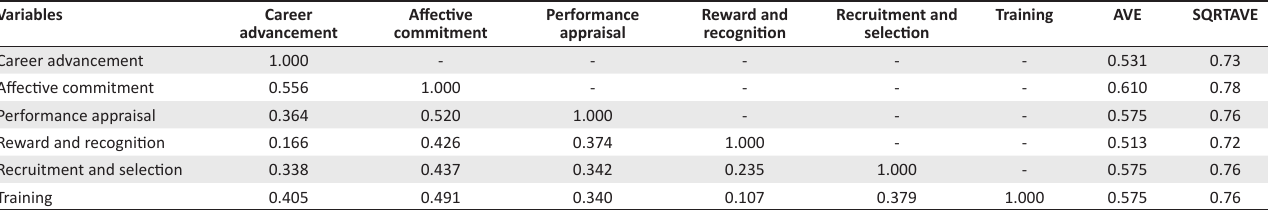
TABLE 3: Result summary for average variance extracted and square root of average variance extracted.